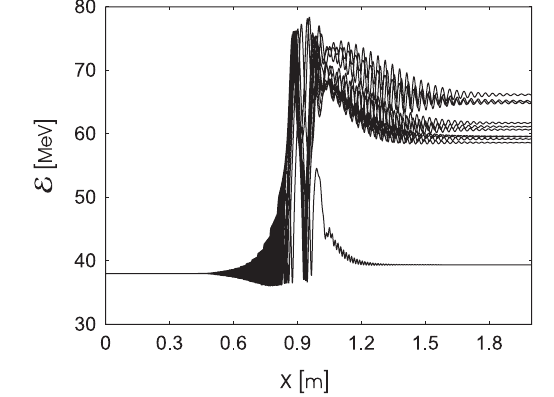
FIG. 5. The initial (dashed line) and final (solid line) energy FIG. 3. Reflection of a particle from a nonplane laser pulse distribution functions for a particle bunch. The interaction pa- with the transverse size of the focused pulse waist w 0 ¼ 500 (cid:4) , at ¼ 0 : 1 , for step l ¼ 2 cm . rameters are the same as in Fig. 3. (cid:2) 0 ¼ 0 : 5 , (cid:5) 0 ¼ 50 T , and (cid:2) u The particles move in this case along the undulator axis x ( y 0 ¼ z 0 ¼ 0 ).